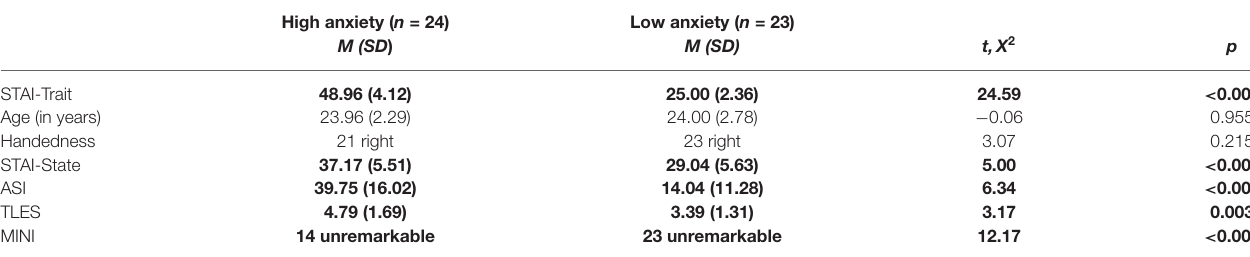
( Table 2 ). Likewise, groups did not differ in startle response magnitude, t ( 44 ) = 1.23, p = 0.226. The HA group reacted more often than the LA group to the US with a startle response, t ( 43 ) = 2.36, p = 0.023 ( Figure 4A ). An ANOVA with the factors Run (1st, 2nd, 3rd acquisition run) and Group was calculated across startle probability, to check whether group differences in probability changed across the course of acquisition. Analysis yielded effects of Group, F ( 1,43 ) = 5.45, p = 0.024, and Run, F ( 2,86 ) = 30.88, p < 0.001, but not of Group × Run, F ( 2,86 ) = 2.79, p = 0.084. Thus, the higher percentage of startle responses in the HA group did not change across the course of fear acquisition, but both groups habituated to the US across time. The higher startle-response frequency in the HA group was paired with an enhanced noise sensitivity, as evidenced by higher GÜF scores in the HA than in the LA group, t ( 45 ) = 5.35, p < 0.001. Startle response frequency was not correlated with subjective US unpleasantness, r ( 43 ) = 0.26, p = 0.080, or GÜF scores, r ( 43 ) = 0.28, p = 0.063, and neither was US unpleasantness associated with GÜF, r ( 45 ) = 0.02, p = 0.901 (Bonferroni- corrected p = 0.05/3 = 0.017).